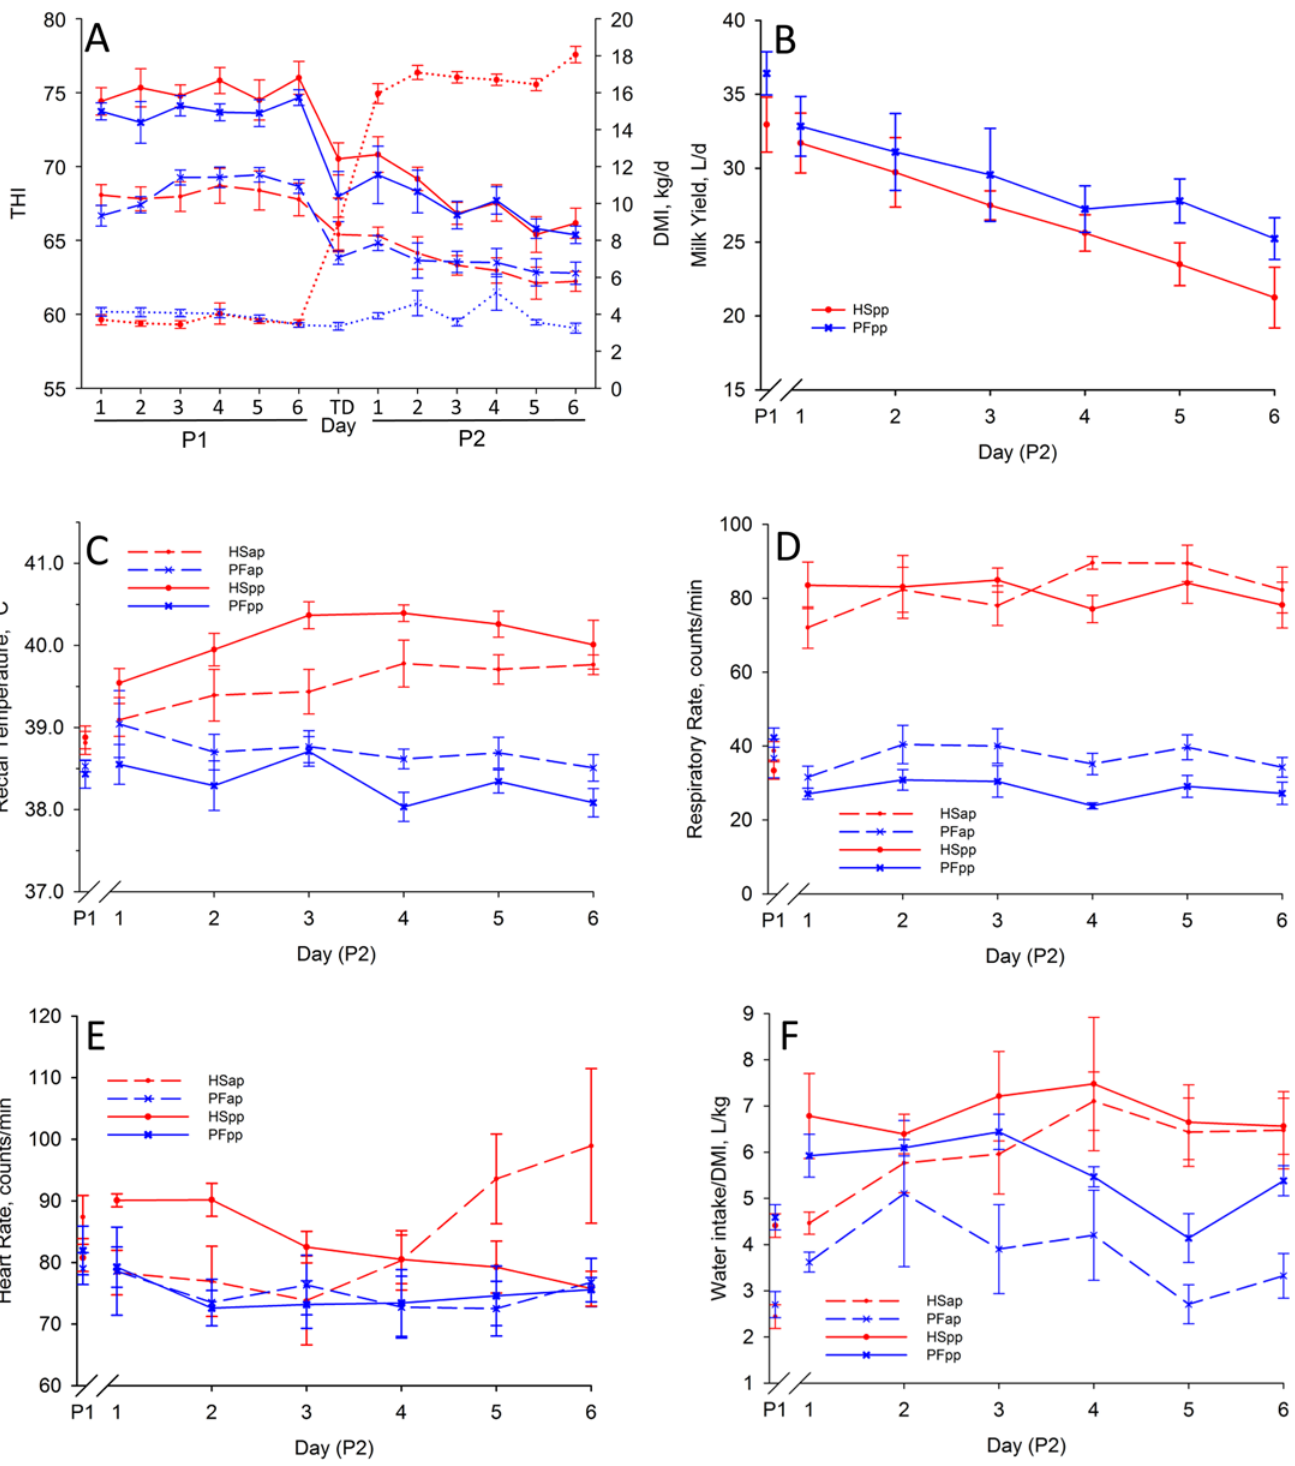
Fig 1. Nutritional and Vital Data. (A) Temperature humidity index (THI, solid or dashed lines), and dry matter intake (DMI; dotted lines; given as mean of both heat-stressed (HS, red) and pair-fed groups (PF, blue), respectively) during the six days of P1 and P2 and the transition day (TD). Effects of HS and PF on (B) daily milk yield, (C) rectal temperatures, (D) respiratory rate, (E) heart rate and (F) Water intake/DMI. In experimental period 1 (P1) all animals were kept at thermoneutral conditions (THI = 59.7) with ad-libitum feeding for six days. During period 2 (P2), HS cows (red lines) were heat-stressed (THI = 76.1), whereas PF cows (blue lines) were pair-fed in thermoneutrality (THI = 60.0) for six days, once ante partum (ap, dashed lines) and again post-partum (pp,